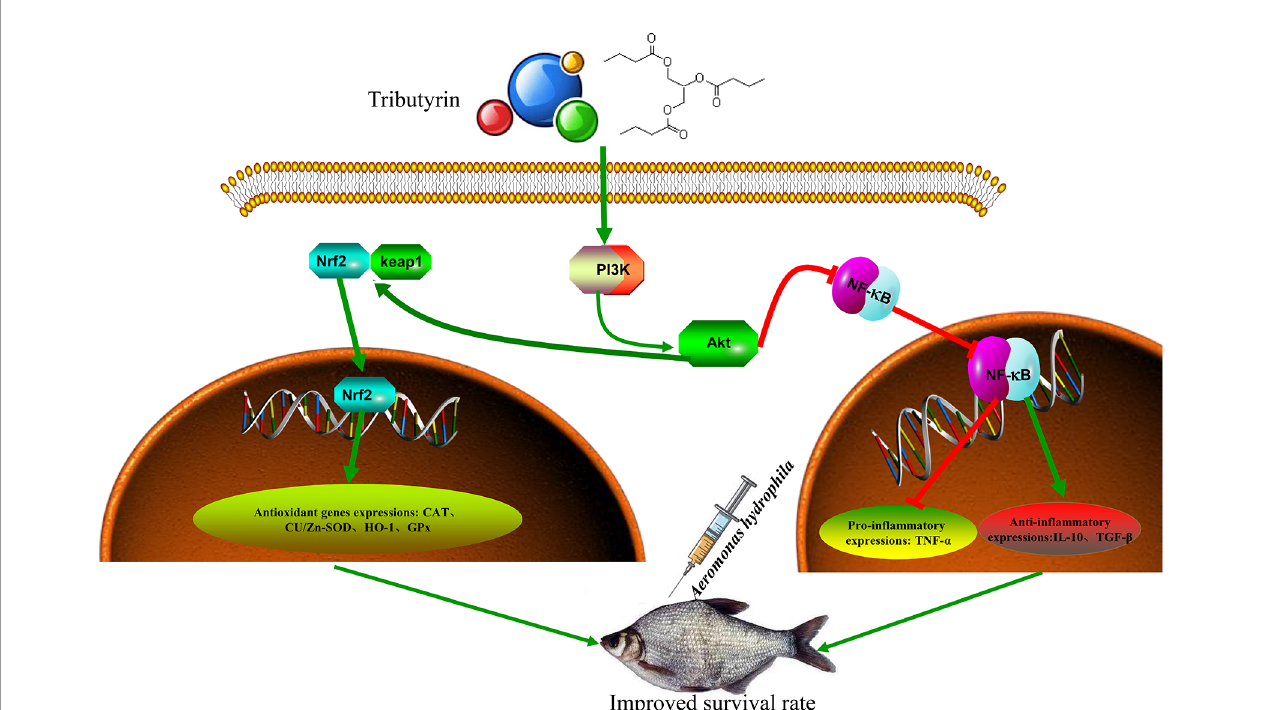
FIGURE 9 | Regulation Mechanism of improving health status by tributyrin in Megalobrama amblycephala